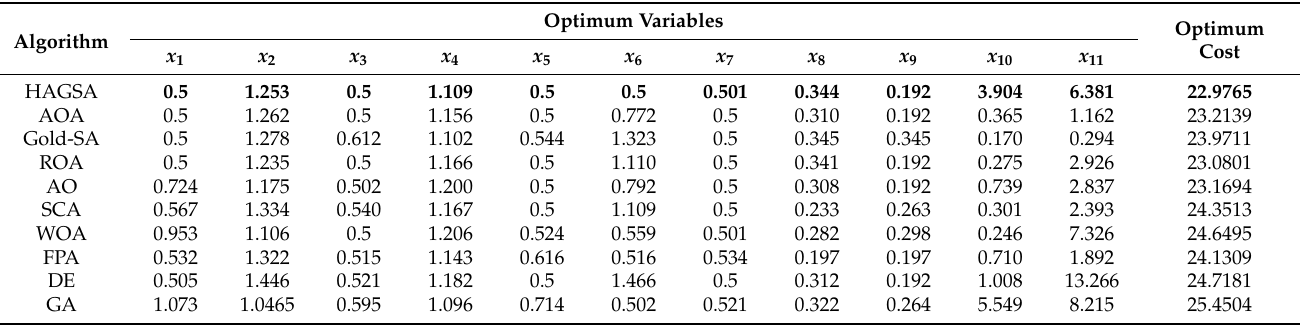
Table 6. Statistical results of car side crash design